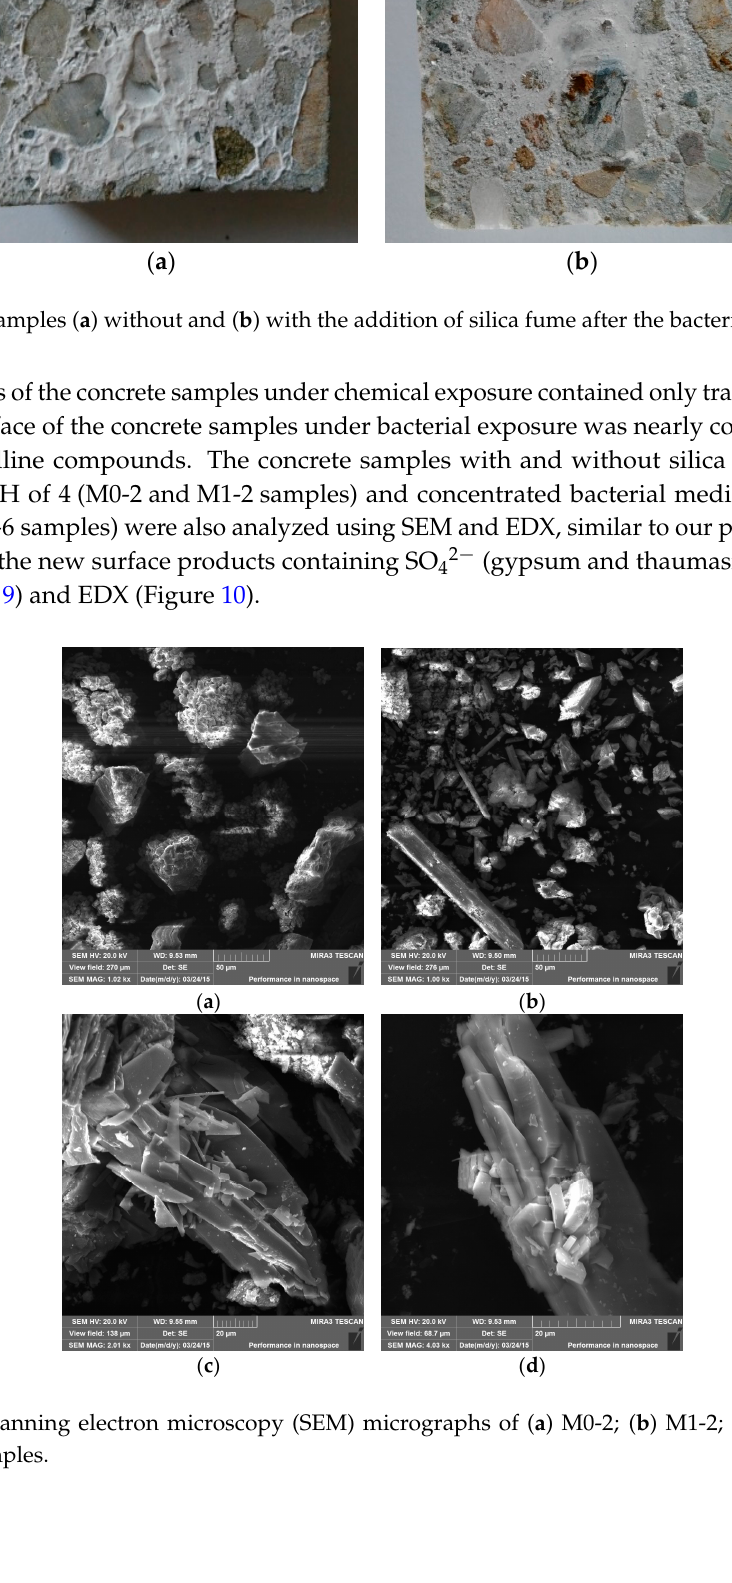
Figure 7. Samples ( a ) without and ( b ) with the addition of silica fume after the chemical exposure.